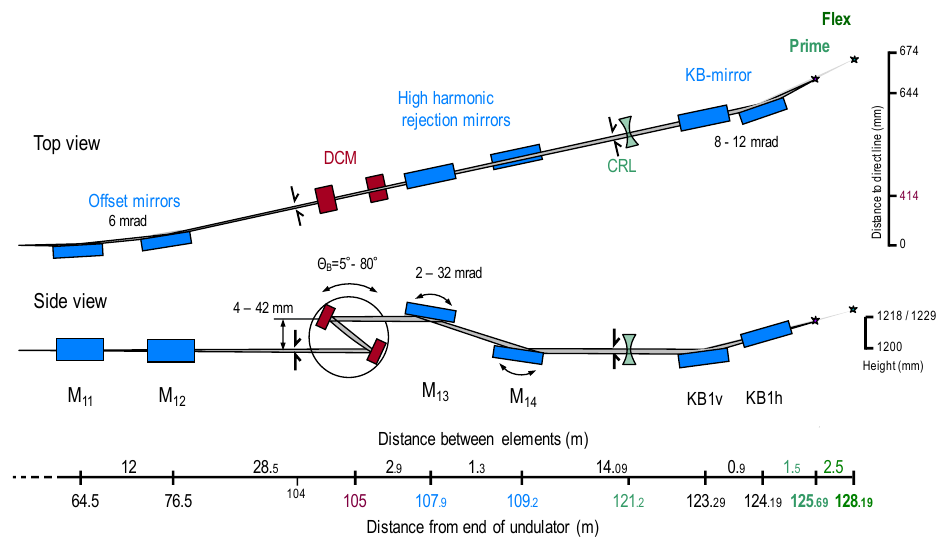
Figure 14. Schematic layout of the X-ray optics at the Aramis-1 beamline. Note the compound refractive lenses (CRLs) are a possible future